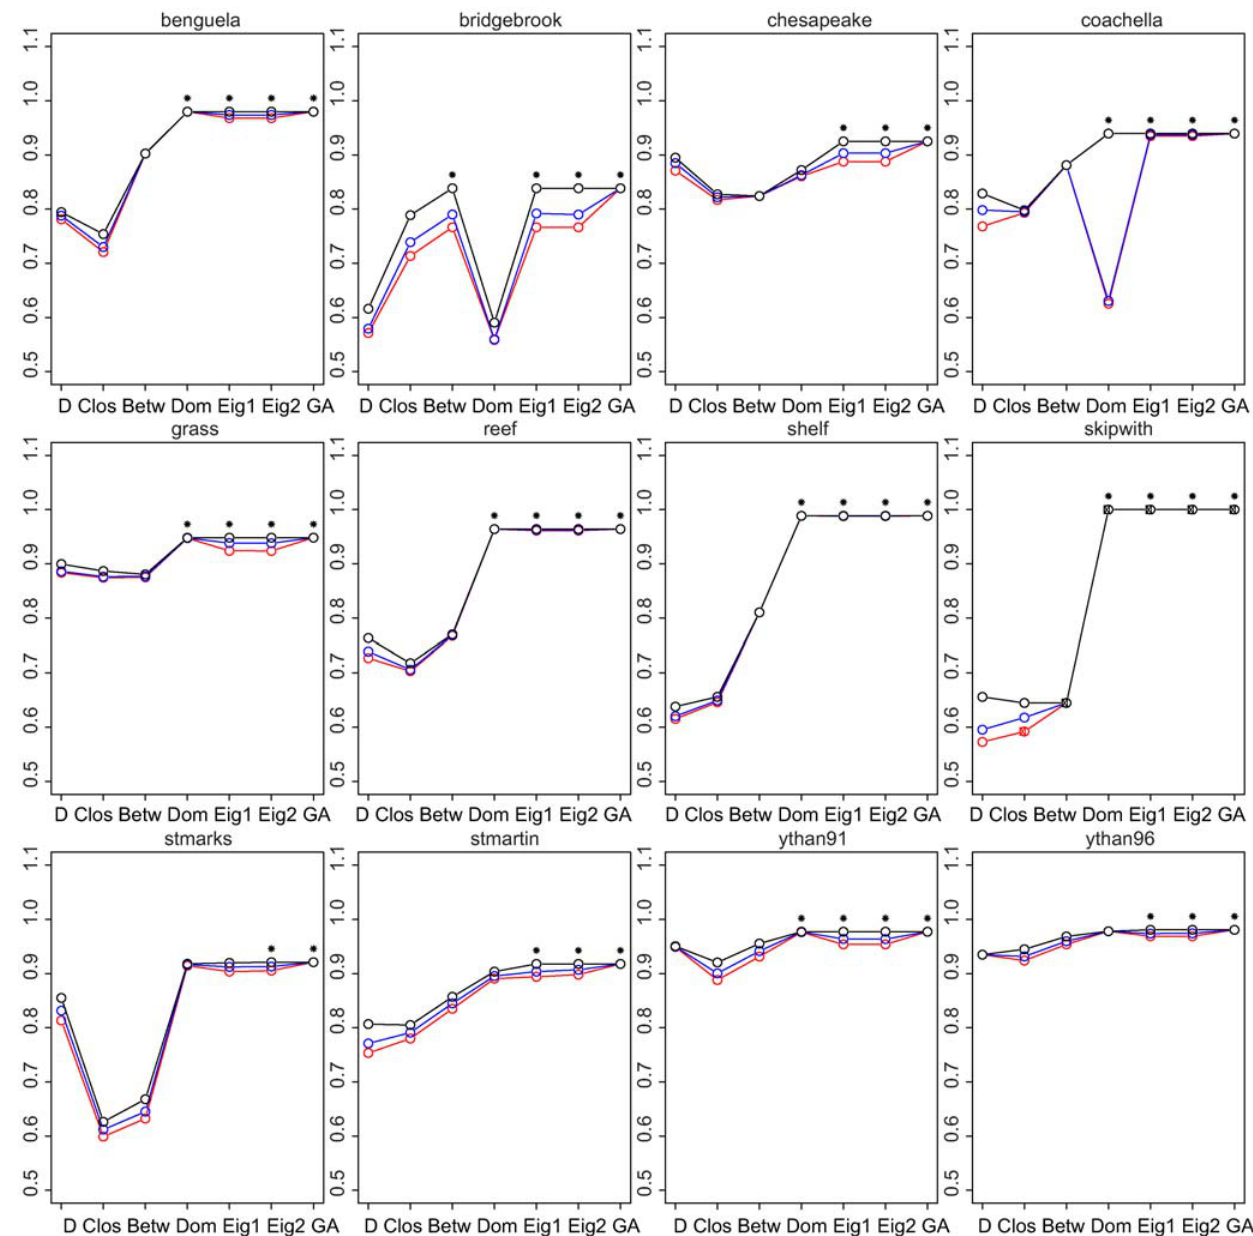
Figure 3. Extinction areas for 12 published food webs (Table 1) according to the 7 algorithms presented in the text. The area is 1 (as in the ‘‘skipwith’’ [30] food webs) only when there is a single primary producer. Because each algorithm can give raise to several solutions, we report the minimum (red), mean (blue) and maximum (black) registered extinction area. We indicate with an asterisk ‘‘*’’ the algorithms that are able to match the performance of the genetic algorithm